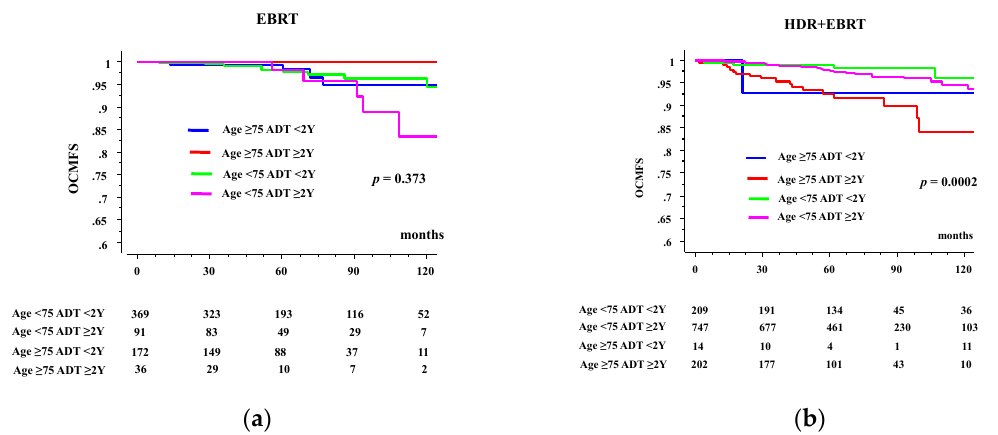
Figure 2 . OCM according to duration of ADT and age. ( a ) OCMFS in external beam radiotherapy (EBRT) group. ( b ) OCMFS in high dose rate brachytherapy plus EBRT (HDR+EBRT) group.